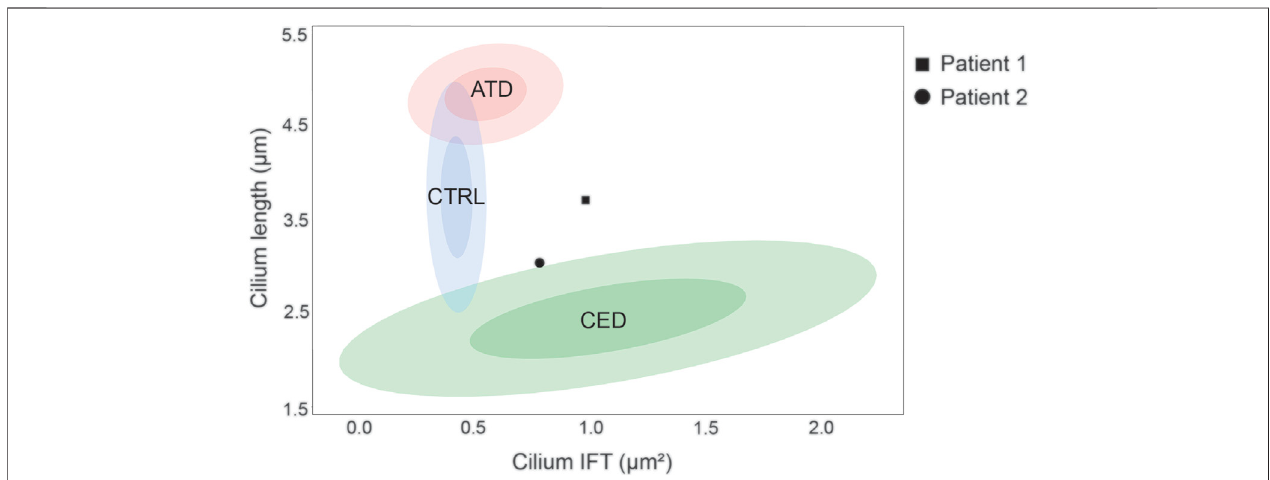
FIGURE2| Ciliopathyciliumphenotypeclusters.Theciliumphenotypeclustersarebasedontwociliumparameters;ciliumlength( Y -axis)andIFT88measurement ( X -axis) published in Doornbos et al. (Doornbos et al., 2021). The con fi dence intervals (CI) of 0.5 and 0.9 are indicated per identi fi able group, i.e. the control, ATD, and CED cohorts. The cilium phenotype of patient 1 showed a normal cilium length (3.71 ± 0.07 µm) and an increased IFT88 measurement (0.99 ± 0.08µm 2 ), therefore it does not fi t in any cluster. Patient 2 showed a decreased cilium length (3.04 ± 0.15 µm) and an increased IFT88 measurement (0.79 ± 0.08µm 2 ), therefore it is positioned on the border of the CED